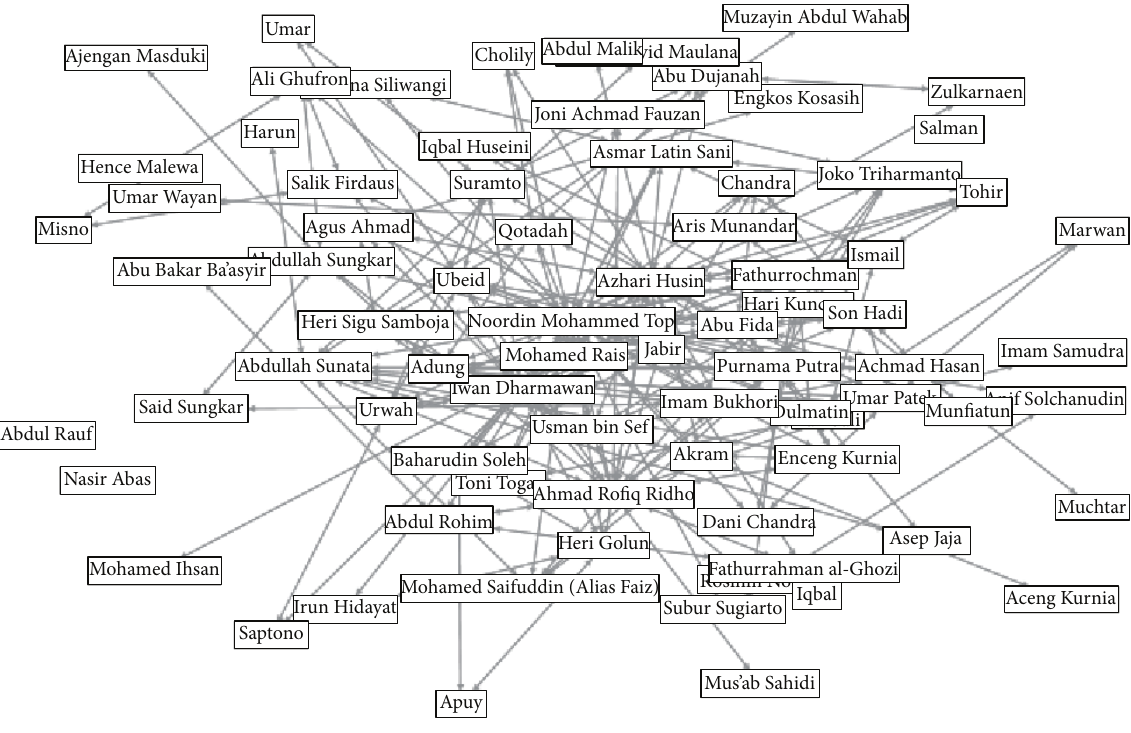
Figure 7: The Noordin Muhammad network.